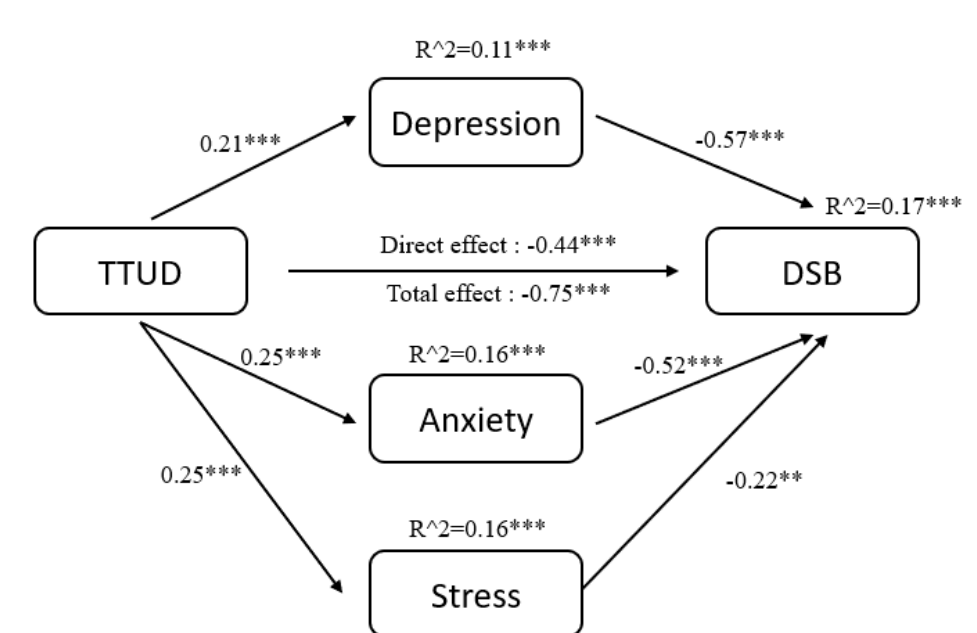
Figure 3. Structural model of backward digit span test for male and female participants. DSB, backward digit span. ** p < 0.01, *** p < 0.001.